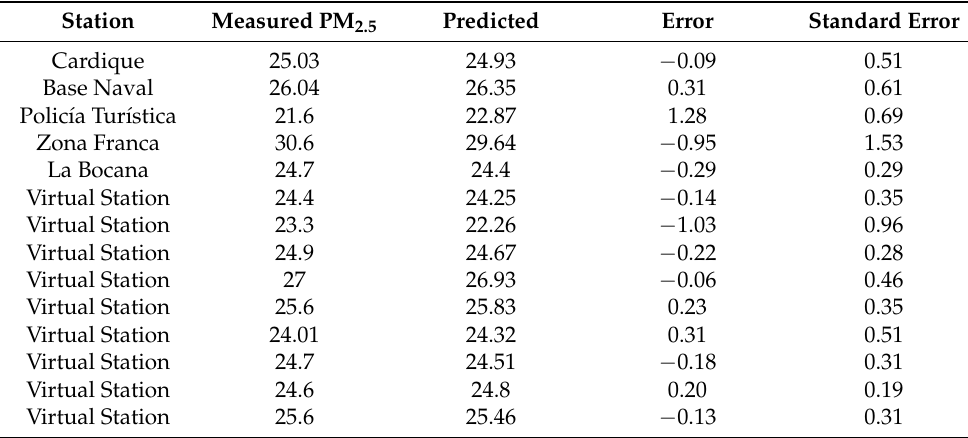
Table 8. Mean errors for each interpolation method.